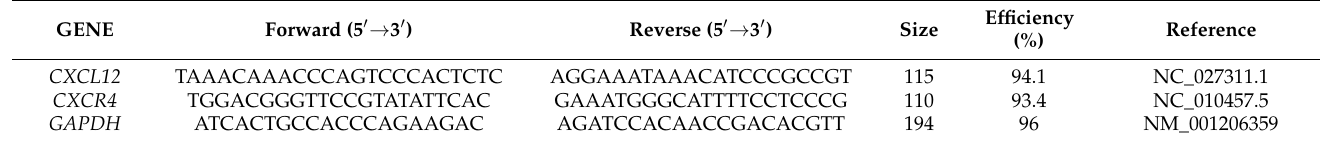
Table 1. Primer sequences for the analysis of mRNA gene